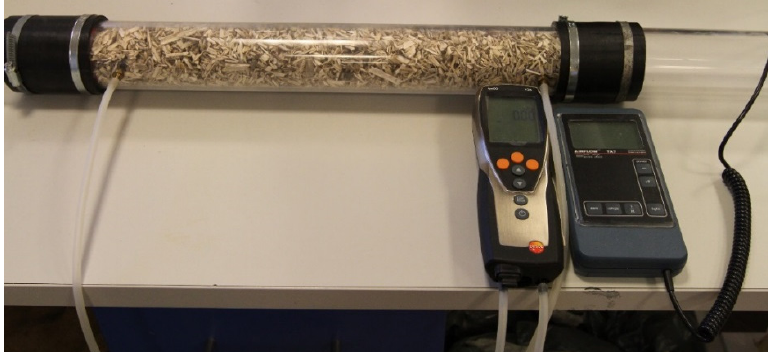
Figure 3. The apparatus for air permeability measurements filled with hemp